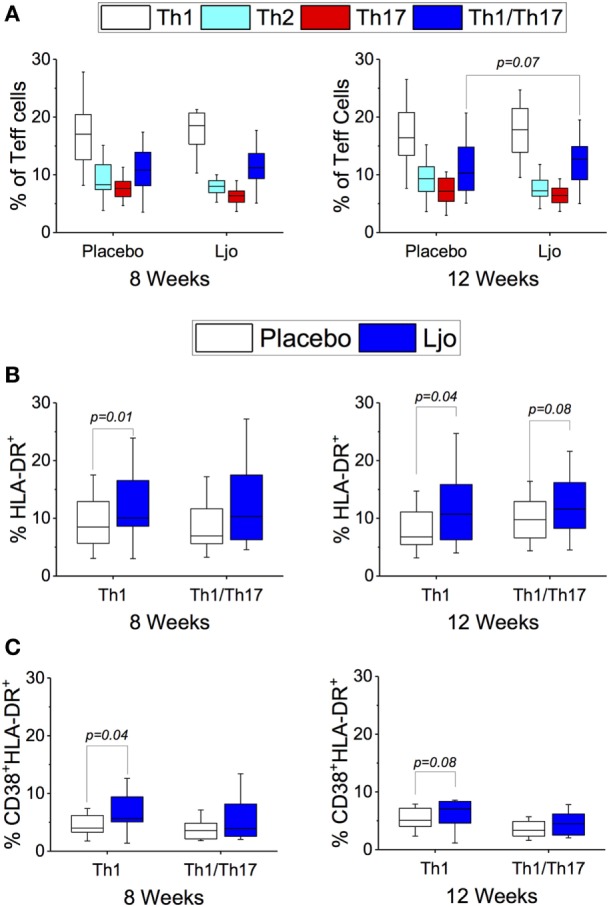
T effector cells subset (CD3+CD4+CD45RO+). (A) Th1 (CD183+CD196−), Th2 (CD183−CD196−), Th17 (CD183−CD196+), and Th1/Th17 (CD183+CD196+) were labeled with specific antibodies and quantified in the placebo (white bars) and L. johnsonii N6.2 (Ljo, blue bars) group at 8 and 12 weeks of treatment. (B) HLA-DR+ and (C) HLA-DR+CD38+ are shown for the Th1 and Th1/Th17 effector T cells. The concentration of cells shown has been normalized to the concentration found at time 0 for each subject.